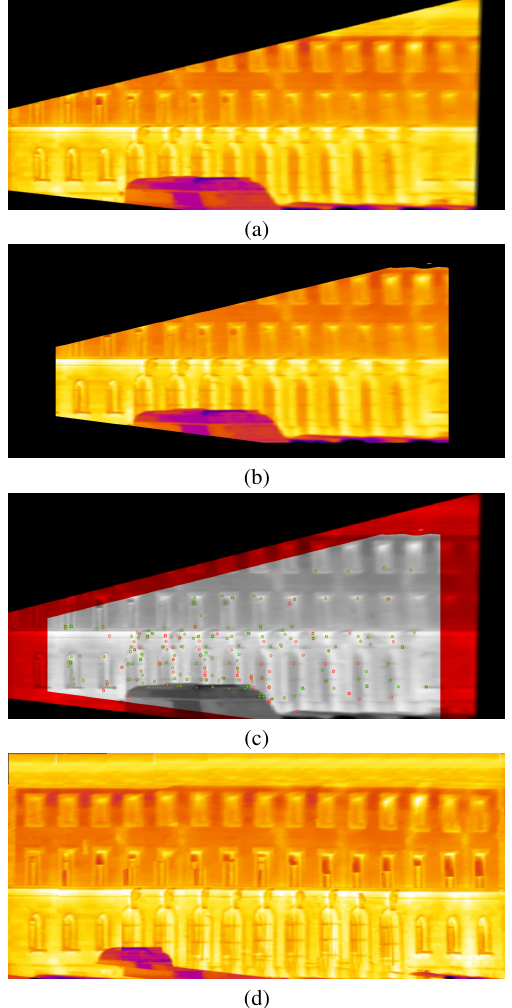
Figure 6. Facade texture combined from several partial textures. a)+b) Two partial textures extracted from the same image se- quence. c) Co-registered overlay of (a) and (b). Green: Interest points in image (a). Red: Interest points in image (b). d) Final composed